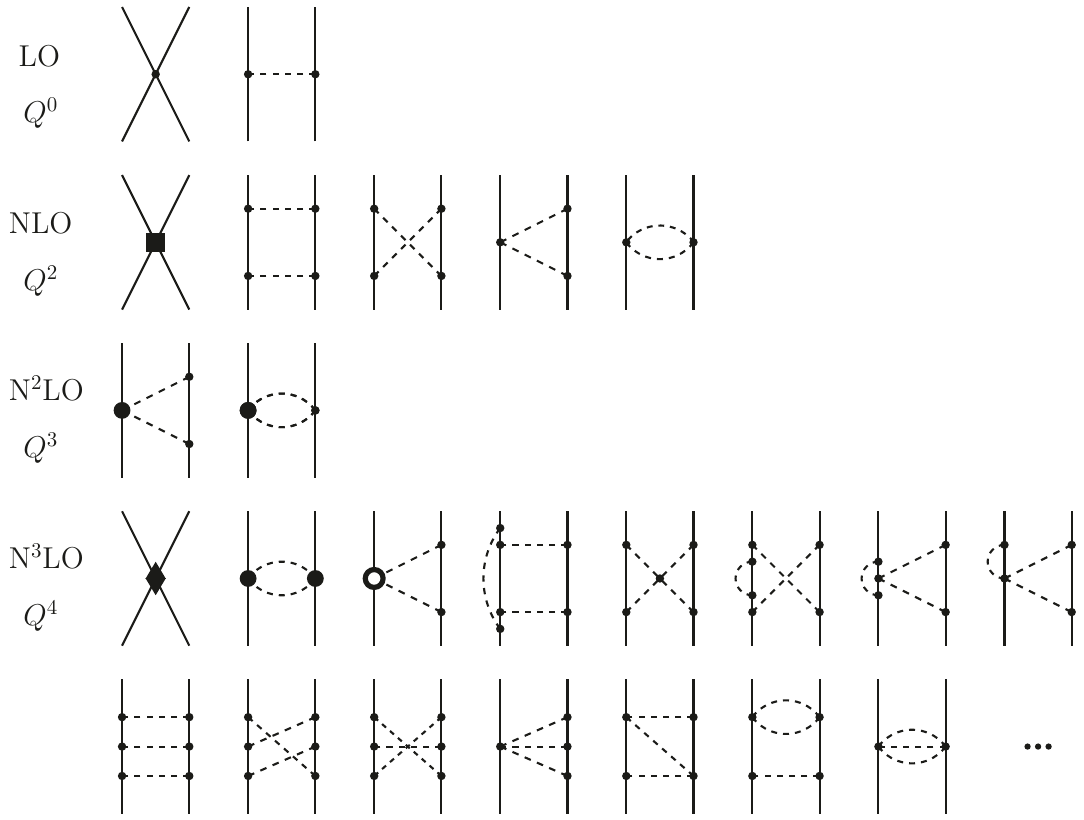
Figure 1 . Relevant diagrams up-to-and-including N 3 LO. Solid and dashed lines denote antinu- cleons/nucleons and pions, respectively. The square and diamond symbolize contact vertices with two and four derivatives, respectively. The dots denote a leading (cid:25)N vertex, while the (cid:12)lled circle and the ring symbolize subleading and sub-subleading (cid:25)N vertices, respectively. Q denotes a small parameter (external momentum and/or pion mass). From the iterated diagrams at NLO and N 3 LO, only the irreducible contribution is part of the